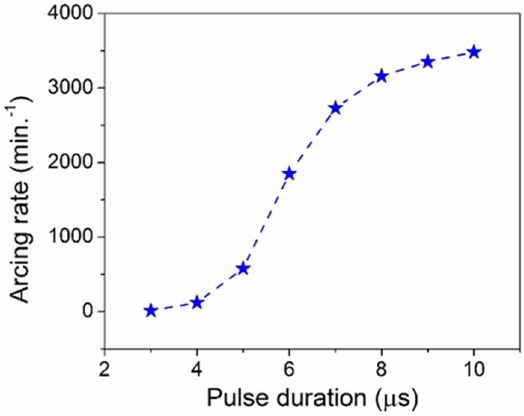
Figure 3. Arcing rate as a function of the pulse duration. Dashed line is used only to guide the eyes.